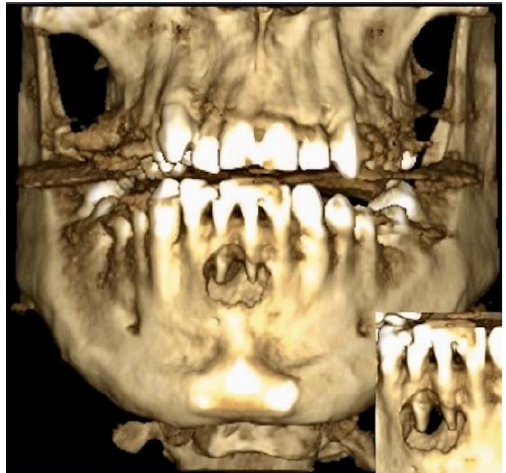
Figure 1. A CBCT reconstruction taken on the first appointment showing bone resorption in a tunnel-like fenestration around the central incisors of the lower jaw.